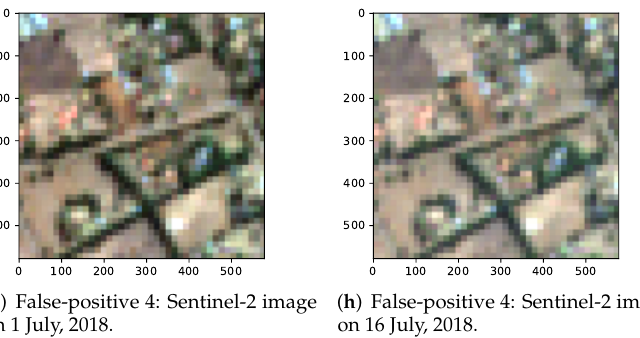
( g ) False-positive 4: Sentinel-2 image ( h ) False-positive 4: Sentinel-2 image on 1 July, 2018. on 16 July, 2018. Figure 21. Visualization of four of the false-positive blobs incorrectly classified by the best classifier.